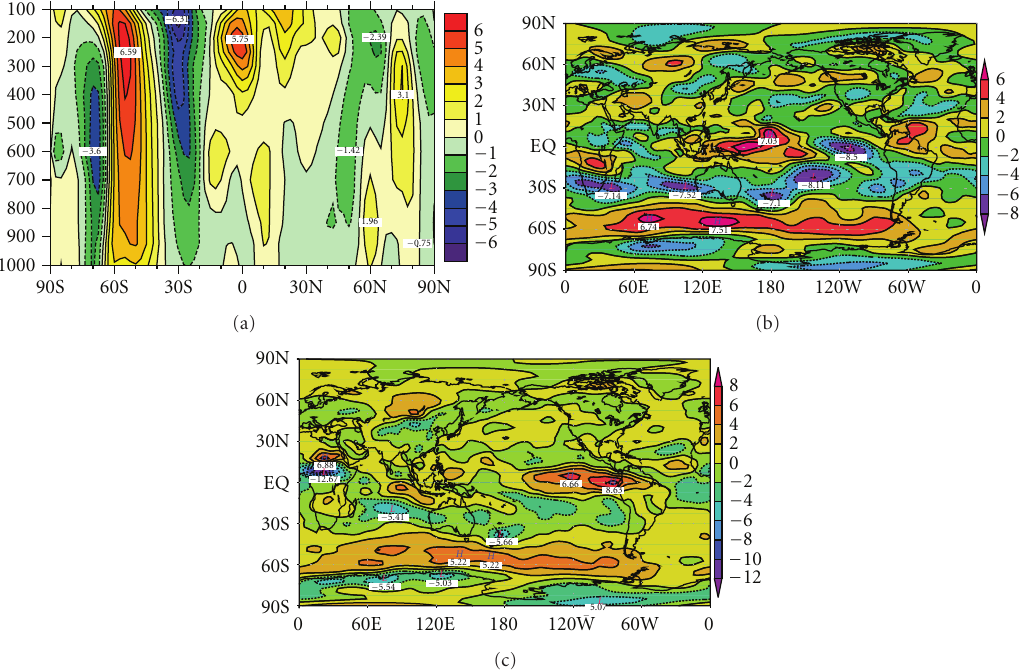
Figure 2: Di ff erence between (1997–2006) and (1949–68) basic states of vertical cross-section of July zonal wind (ms − 1 ) averaged between 110 ◦ and 160 ◦ E as a function of latitude and pressure (in hPa) (a), 300hPa July zonal wind (ms − 1 ) (b) and 700 hPa July zonal wind (ms − 1 )